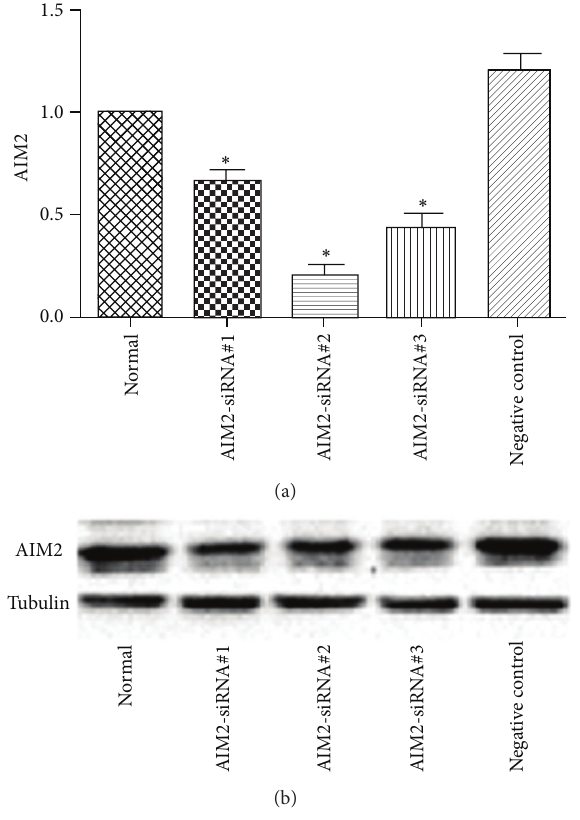
Figure 2: Expression of AIM2 mRNA (a) and protein (b) in transiently transfected HGM cells. AIM2-siRNA#2 was identified as the most effective silencer. AIM2-siRNA was transiently transfected to HGM cells. AIM2-siRNA#1, siRNA#2, siRNA#3 resulted in reduction of expression of AIM2 detected by qRT-PCR with 0.5, 3.8 and 1.3 folds respectively (a). These changes were also noted at the translational level, as measured by Western blot (b). ∗ indicates a significant difference compared with the control ( 𝑃 < 0.01 ). 𝑛 = 3 independent experiment RNA samples for each group.